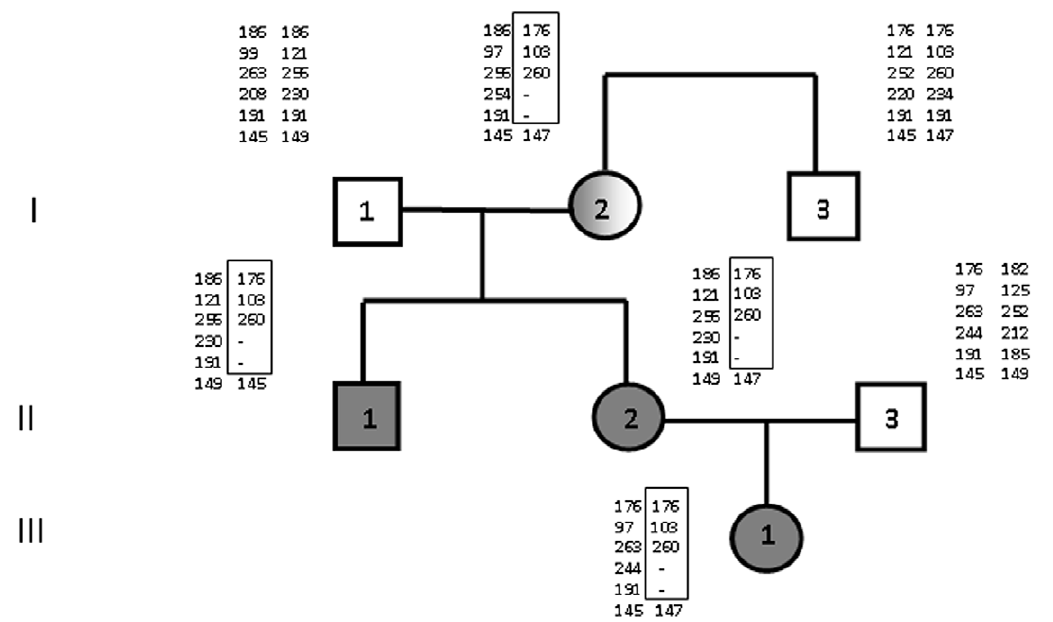
Figure 1. Pedigree of the three generation family showing individual 11p haplotypes. Affected individuals are indicated by full shading, carriers by partial shading. Haplotypes are represented by the allele sizes for each marker in descending order (telomere to centromere), D11S576, D11S922, TH, D11S4088, 244.14 and HBB . Inferred marker deletion is indicated by a dash.